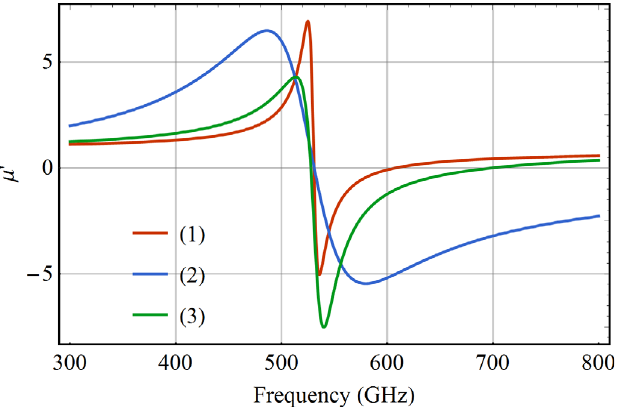
Fig. 16. Phase on re fl ection of a patch array vs. frequency for the Fig. 15. Effective permeability of a SRR array vs. frequency for following three con fi gurations: (1) Initial patch array, C g = C gl = the following three con fi gurations: (1) Initial SRR array, 12.8 pF (2) Ideal negative inductance, C g = C g0 =0.25 pF, L neg = C p =2 pF (2) Ideal negative inductance, C p = 18pF, L neg = (cid:2) 32.2 nH, R V (3) Stable gyrator circuit, C NF =0 (cid:2) 40nH, R V (3) Stable Linvill circuit C L neg = (cid:2) 31.9nH, R NF =3.2 V p =4,4 pF, L neg = NF = 0 (cid:2) 24.4 nH, R V . NF =66